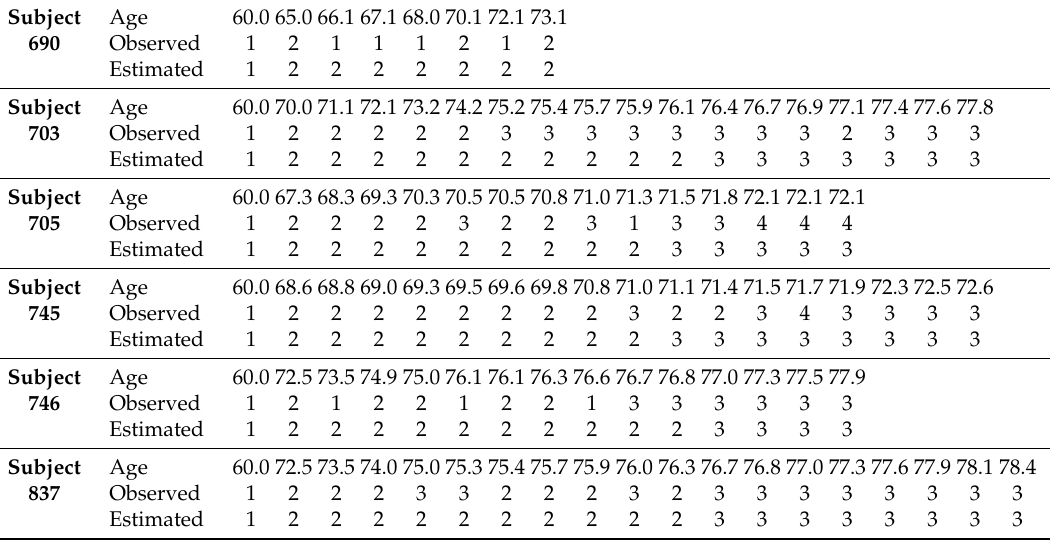
Figure 3. Aneurysm data: observed profiles and corrections for six subjects with measurement errors. Table 7. Aneurysm data: observed and estimated stages for six